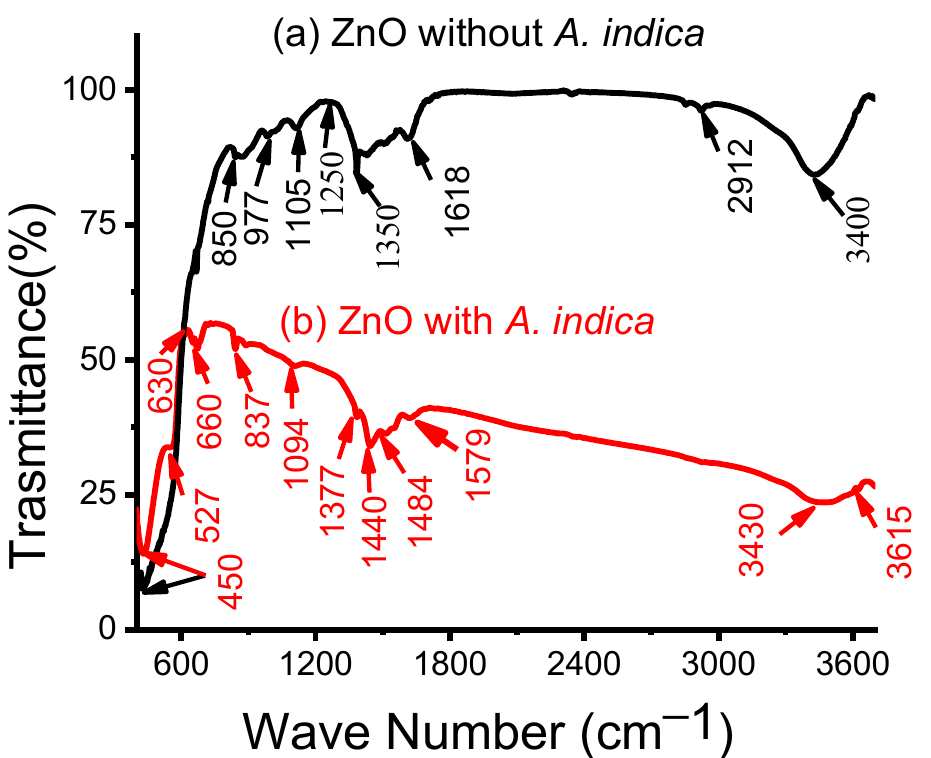
Figure 4. FTIR analysis of ZnO NPs ( a ) without dye extracts, ( b ) with A. indica dye extracts. The peaks viewed in FTIR spectra of ZnO NPs after addition of A. indica such as 3615, 3430, 1579, 1484, 1440, 1094, 837, and 660 cm − 1 show the presence of polyols, terpenoids, and proteins partaking functional groups of amines, alcohols, ketones, and carboxylic acid in bio-reduction responses [26]. Raphael et al. reported that proteins obtained from A.